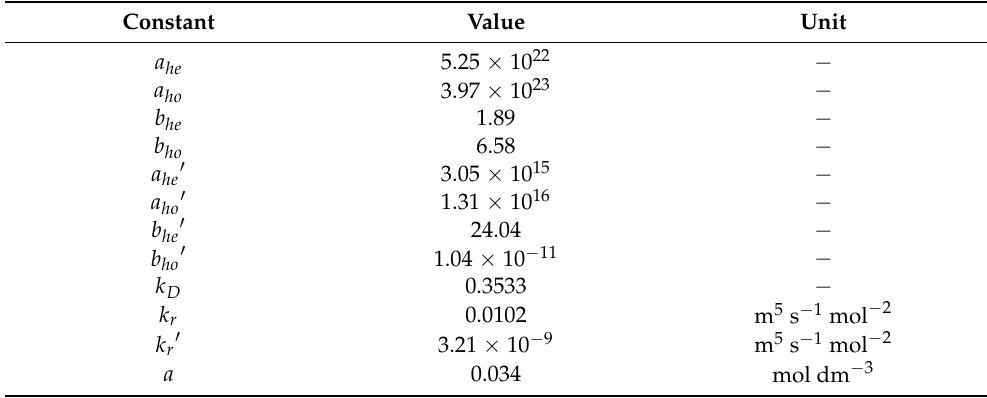
Table 2. Constants for the advanced kinetics model.